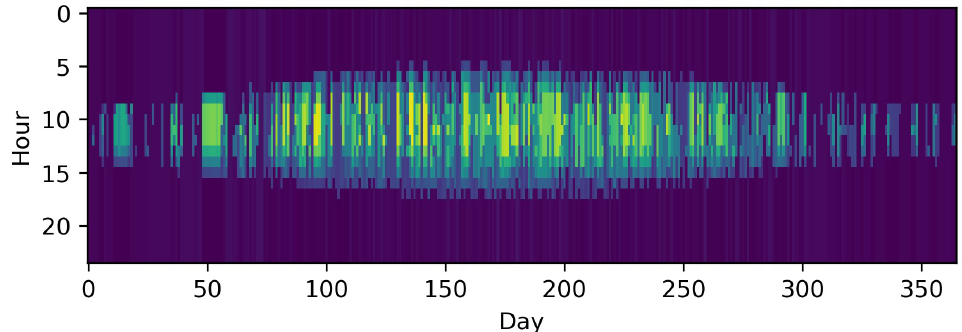
Figure 6. The time series of photovoltaic capacity factors segmented to 1460 time intervals using hierarchical merging of adjacent time steps based on centroids as proposed by Pineda et al. [72].